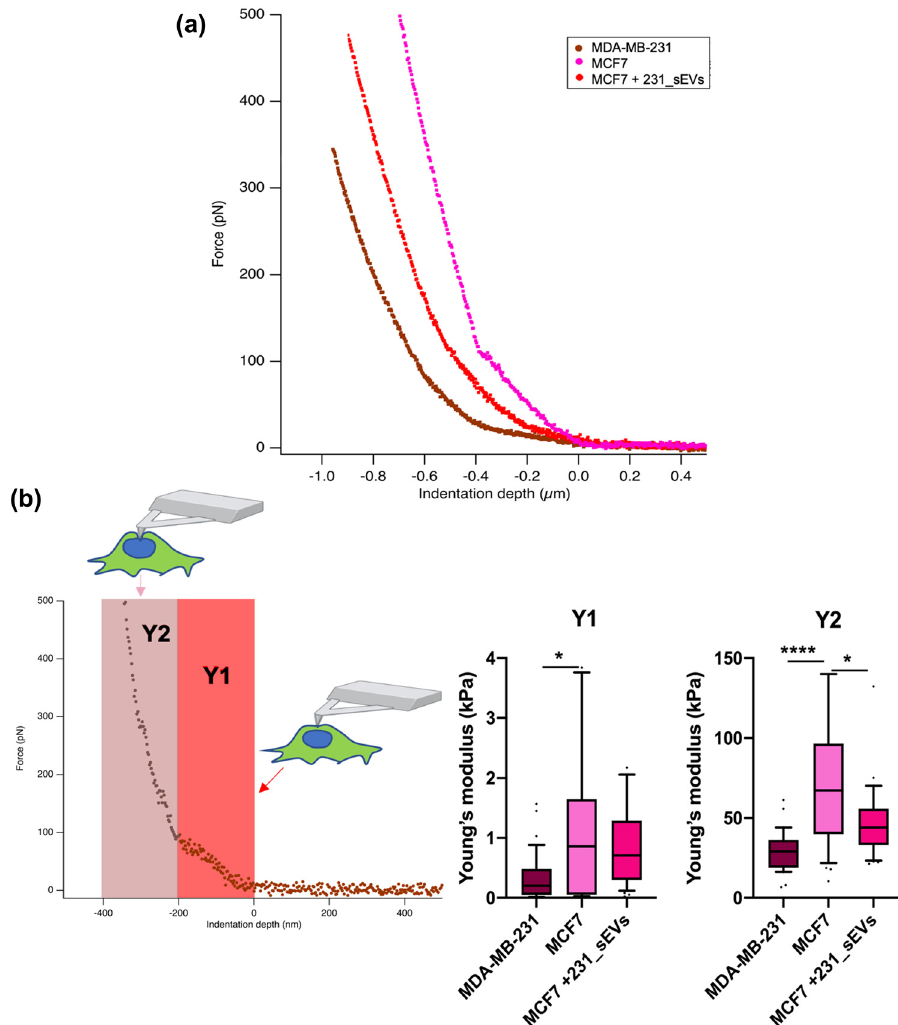
Figure 2: Young ’ s moduli obtained through AFM force spectroscopy of MDA - MB - 231, MCF7, and 231_sEV - treated MCF7 cells. Representative AFM force - indentation curve of cells by using a pyramidal tip ( positioned on the nucleus ) and by using the two - slope modi fi ed Hertz - Sneddon model to fi t the force curves ( a ) ; representative AFM force - indentation curve and boxplots showing the elastic moduli Y1 ( external layer ) and Y2 ( cell body ) of the cells, obtained as described in A ( b ) . The lower and the upper boundaries of the box represent Q1 ( 25 percentile ) and Q3 ( 75 percentile ) of the data, respectively; the horizontal bar inside the box represent the median of the data. Signi fi cance of data di ff erences was established via ANOVA Kruskal – Wallis test ( * p < 0.05; ** p < 0.01; *** p < 0.001; **** p < 0.0001, respectively )